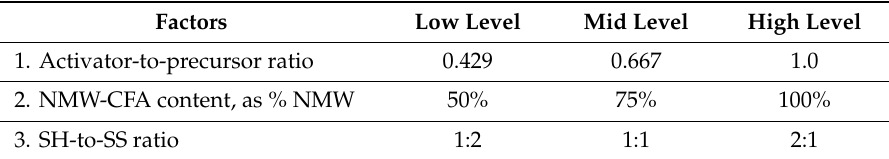
Table 1. Parameters of each factor and level for geopolymer